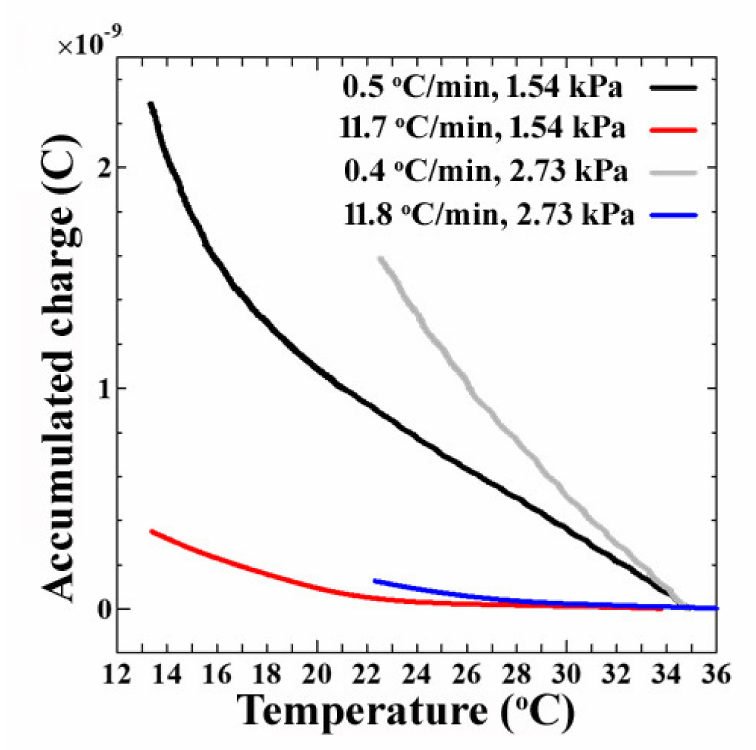
Figure 6. The accumulated charge as a function of the temperature of the sensor’s surface being cooled at 0.5 ◦ C / min or 11.8 ◦ C / min rates from 35 ◦ C at 2.73 kPa or 1.54 kPa vapor